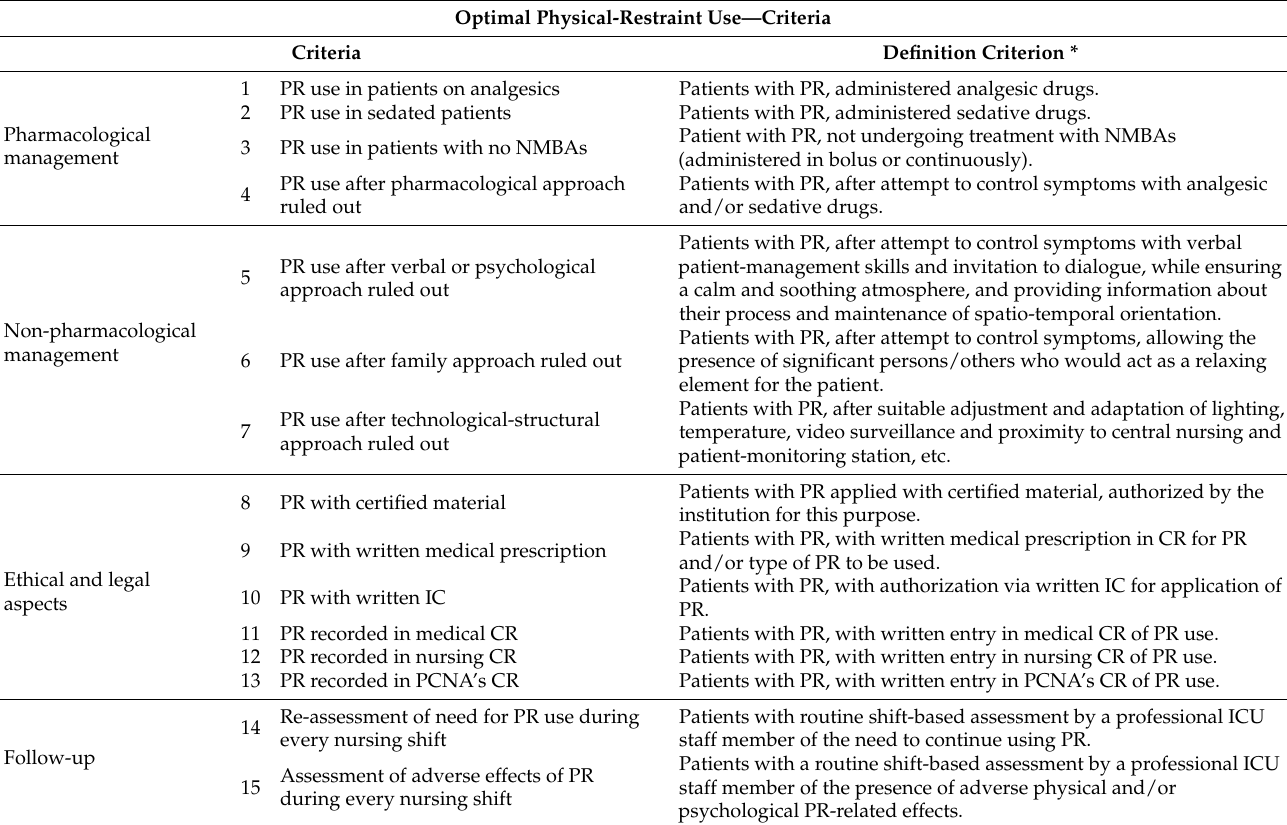
Table 5. Optimal use of physical